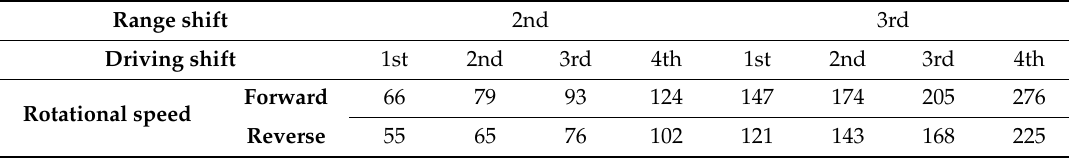
Table 1. Calculated rotational speed of transmission by each gear ratio at engine-rated rotational speed. Range shift 2nd 3rd Driving